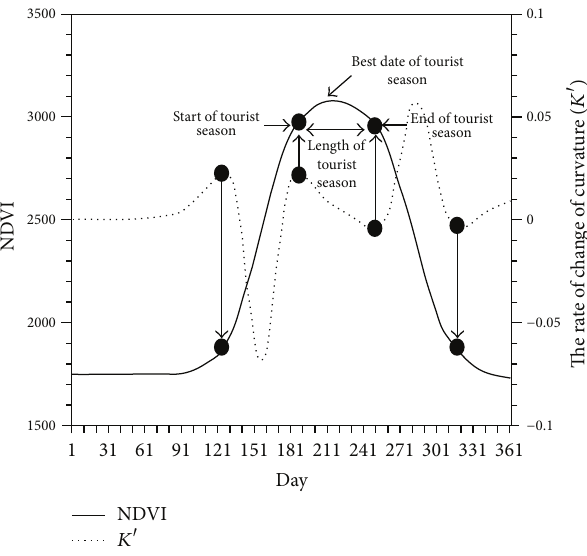
Figure 2: The reconstructed NDVI time series and the dates of tourist